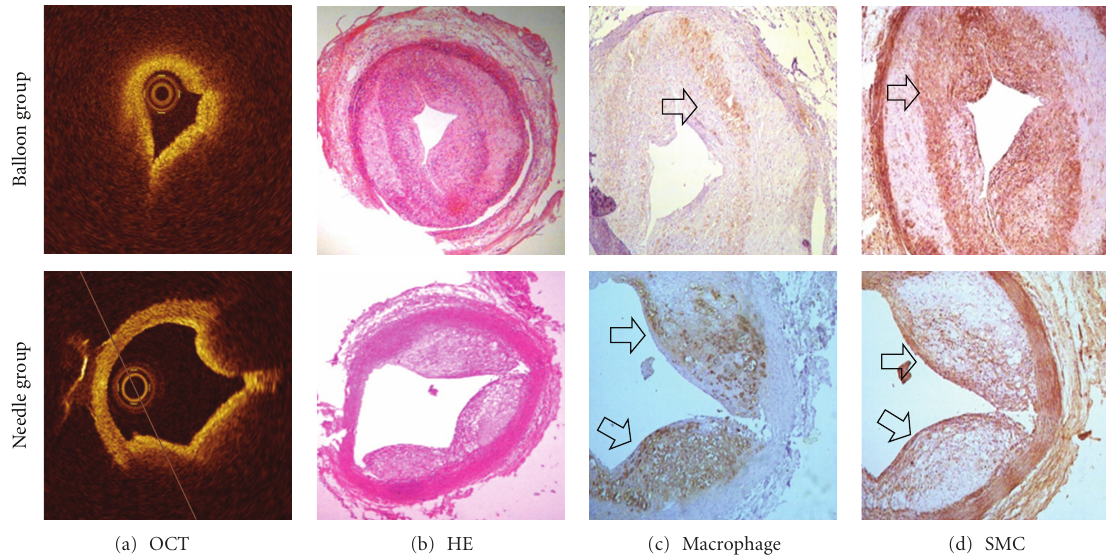
Figure 4: Representative cross-sectional images of the balloon-injury group and needle-injury group. (a): a concentric plaque with a lipid- rich core and thick fibrous cap from the balloon-injury group and eccentric plaque with a lipid-rich core and thin fibrous cap from the needle-injury group; (b): corresponding histology sections with a similar shape from the two injury groups; (c): immunostaining for macrophages by anti-CD68 antibody (arrows in (c)), which demonstrate greater accumulation of macrophages in the needle-injury group relative to the balloon-injury group; (d): immunostaining for smooth muscle cells (SMCs) by anti-SMC α -actin antibody. The fibrous cap of the plaque in the balloon-injury group contains more SMCs compared with that in the needle-injury group. The original magnification in figure (b) is × 40, whereas in (c) and (d) it is × 100.